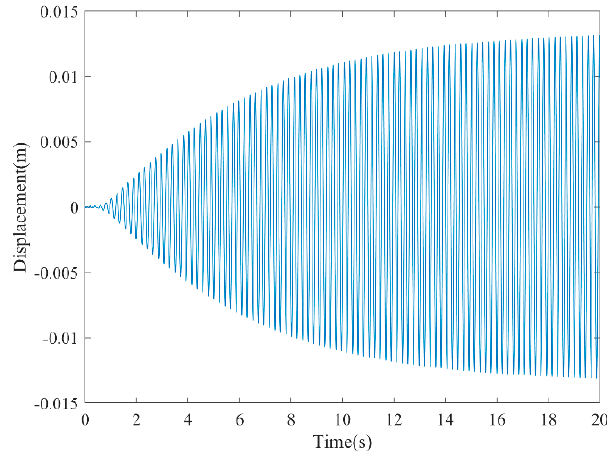
Figure 10. Phase portrait (limit cycle oscillation) ( U = 1.8 m/s).